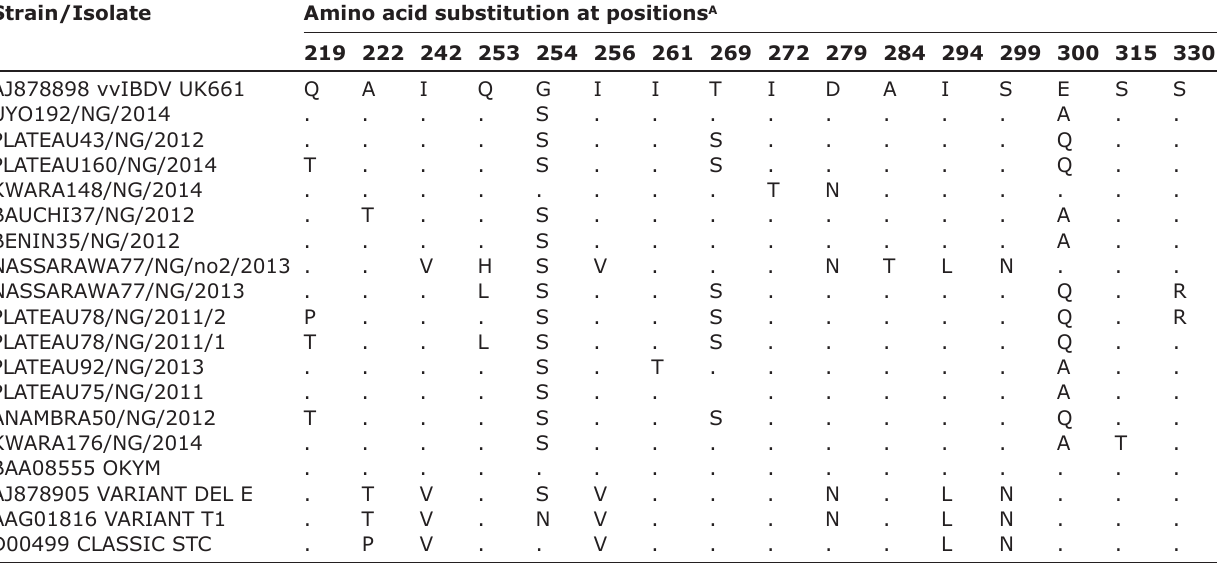
Table-1: Comparison of genome segment A amino acid substitutions at selected positions between Nigerian field viruses and other published strains of IBDV.